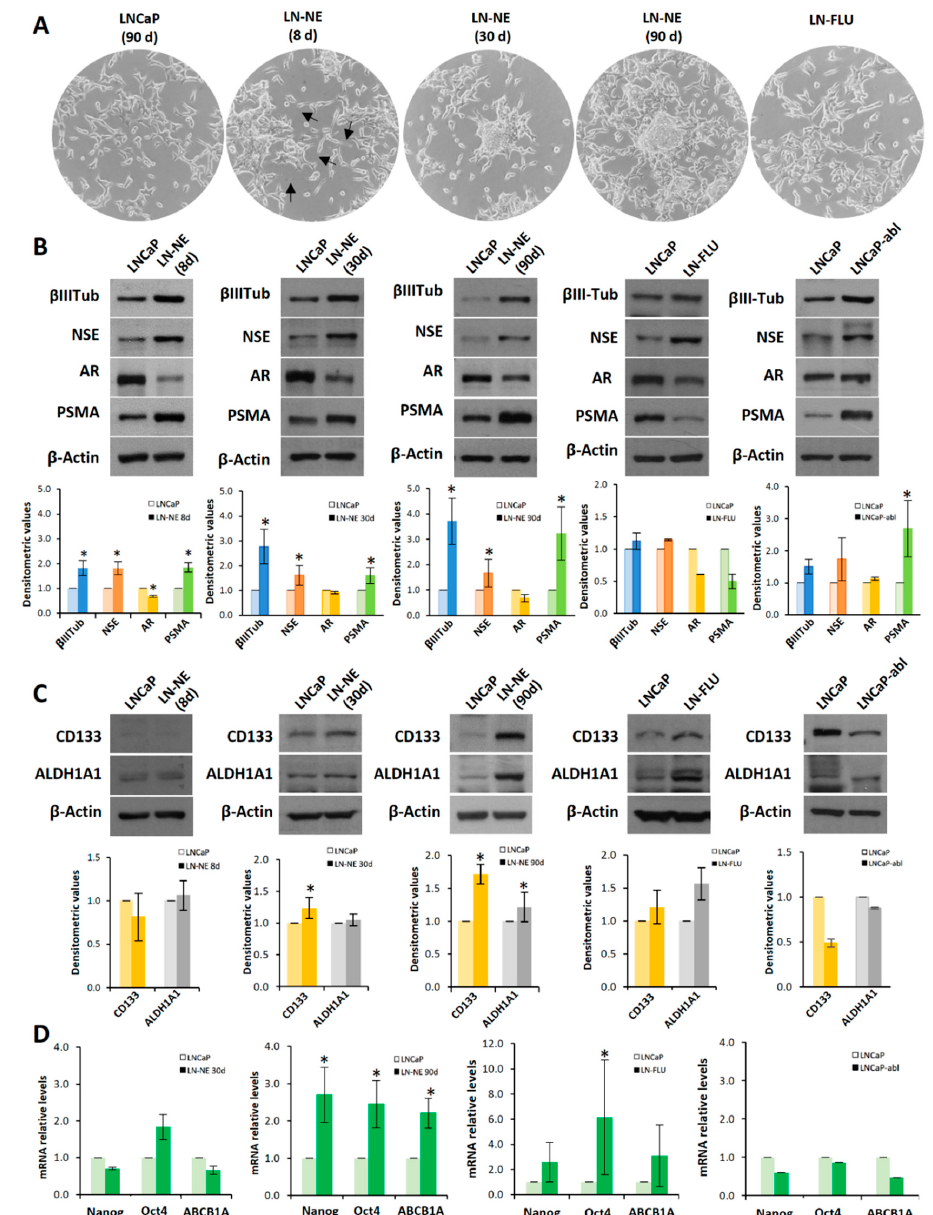
Figure 1. Long-term androgen withdrawal induces di ff erentiation to prostate stem-like cells. ( A ) LNCaP and LN-NE cells were maintained in medium with or without androgens respectively. LN-FLU cells were adapted to grow in the presence of 2-hydroxyflutamide (FLU) for 2 months. The morphological appearance of the LN-NE cell line was observed by phase contrast microscopy at three di ff erent times: 8, 30, and 90 days, and that of the LN-FLU cell line at two months. Arrows point to neurites in LN-NE 8d cells. ( B ) Levels of expression of NED markers were determined by Western blot and limited to actin as a load control. The cell line LNCaP-abl was used for comparison. A representative image of three experiments is shown. ( C ) Levels of expression of CSC markers were determined by Western blot. Densitometric analysis (n = 3) is shown below each image. ( D ) Levels of expression of cancers stem cell (CSC) markers determined by qPCR. The data show the relative mRNA expression to GAPDH, which was used as a housekeeping gene. Data represent the mean ± SD of three independent experiments. * p < 0.05 significant di ff erence between LNCaP and LN-NE cells or LNCaP and LN-FLU cells by two-way ANOVA and Sidak’s multiple comparisons